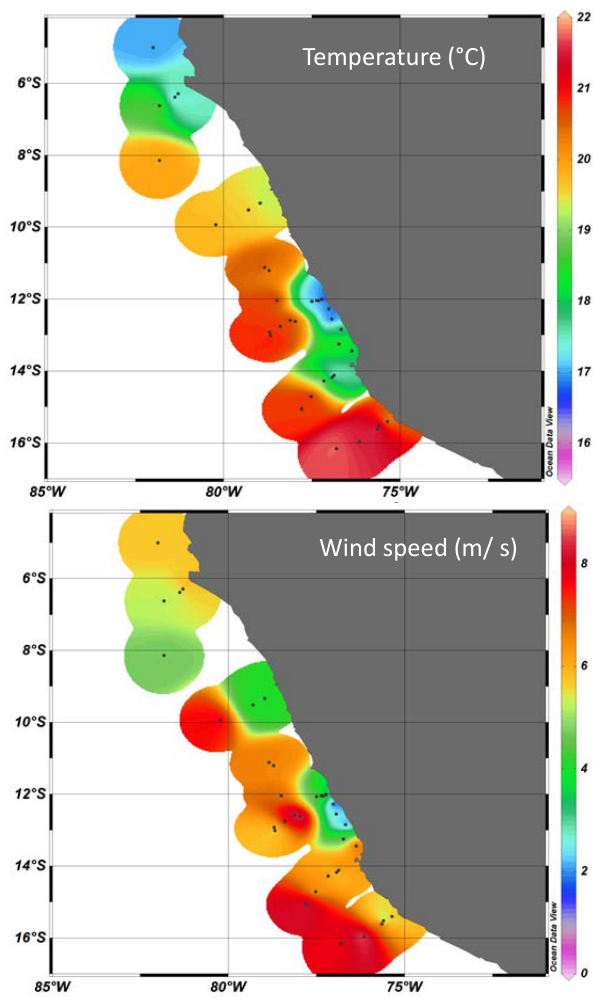
Figure 2. (a) Surface water (1m depth) temperature ( ◦ C) and wind speed (ms − 1 ) (b) during